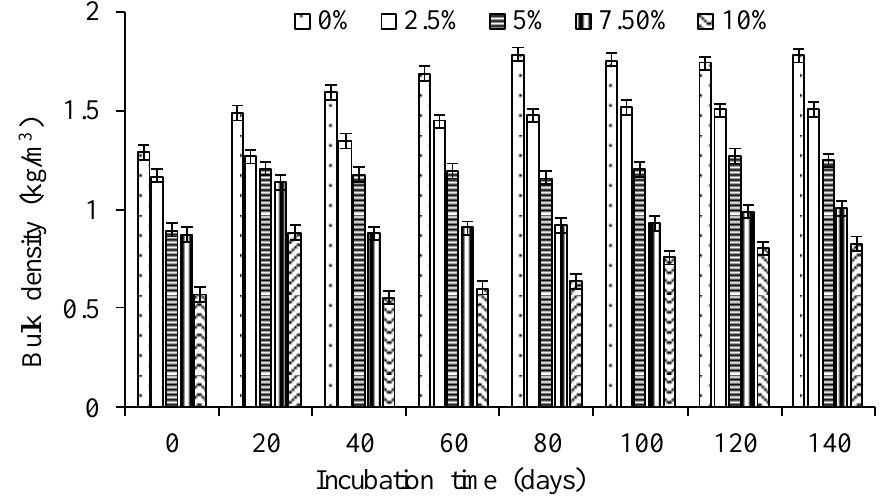
Figure 5. Changes in bulk density during incubation of a Hutton soil amended with different biochar rates. Error bars indicate SD.